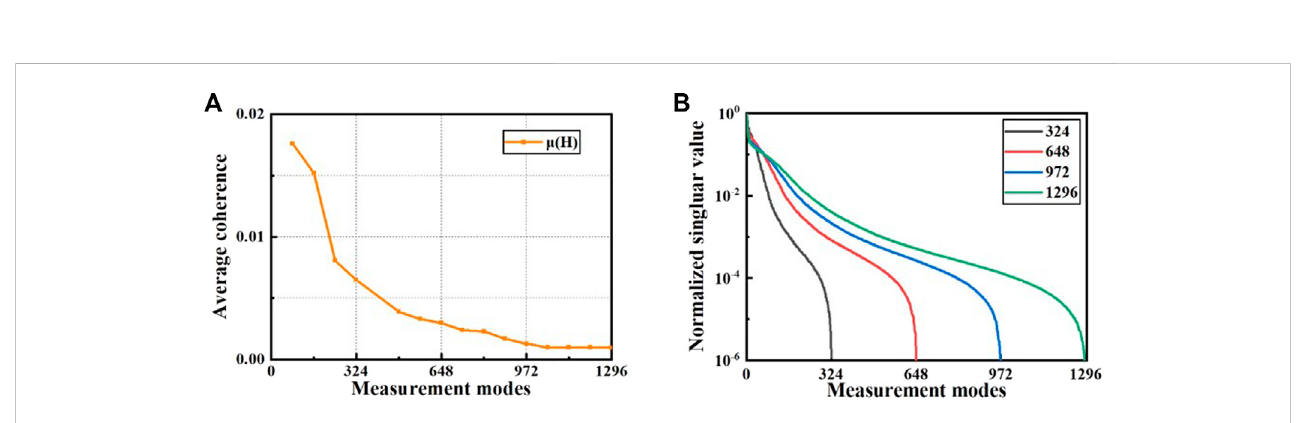
FIGURE 5 (A) µ (H) of the measurement modes. (B) The singular value of the measurement